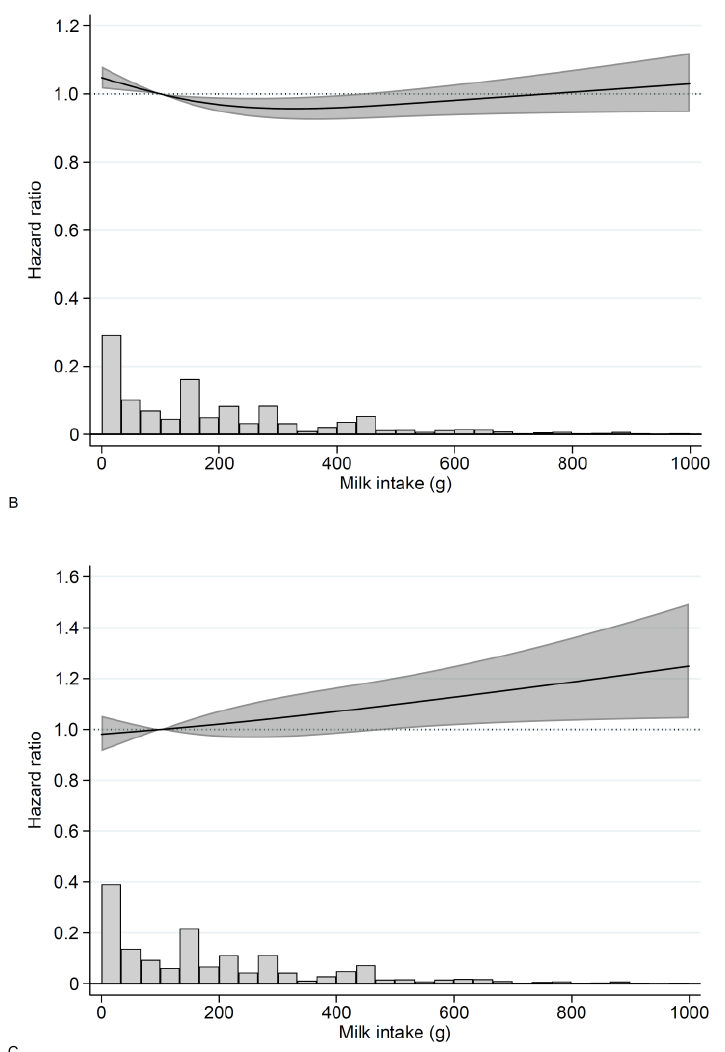
Figure 1. Hazard ratios (solid line) and 95% confidence intervals (gray shaded area) for milk con- sumption and ( A ) total stroke, ( B ) cerebral infarction, and ( C ) hemorrhagic stroke in The Swedish Mammography Cohort and the Cohort of Swedish Men. A total of 100 g/day was used as reference. The distribution of milk intake is shown in the histogram. Time at risk was accrued between 1 January 1998 and 31 December 2019, with time-updated information in 2009. Covariates included in the model were sex (through stratification), age, educational level, smoking status, physical activity, body mass index, history of hypertension, hypercholesterolemia, diabetes mellitus, coronary heart disease, Charlson’s weighted comorbidity index, vitamin- and mineral supplement use, intakes of total energy, fruit and vegetables, processed meat, soft drinks and juices, alcohol, coffee, fermented milk, total fat, and saturated